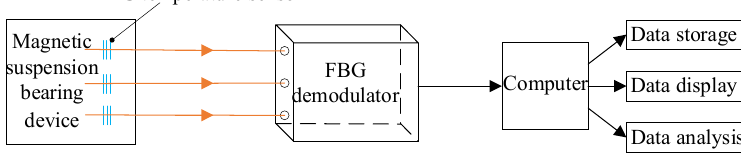
Figure 11. System schematic diagram.